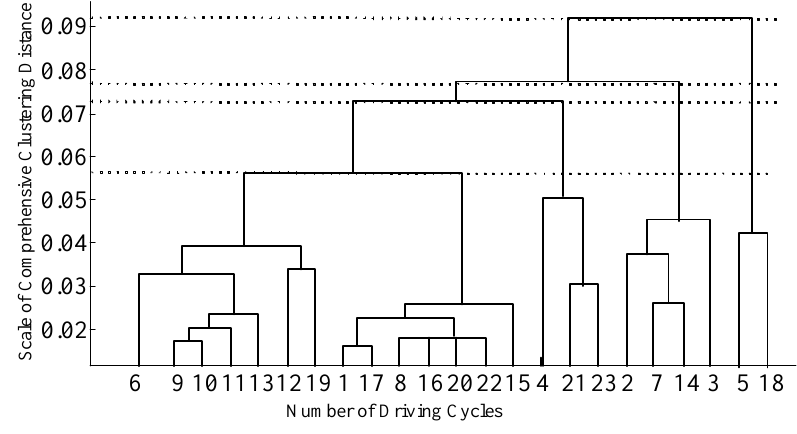
Figure 9. Clustering-feature tree of twenty-three typical patterns.